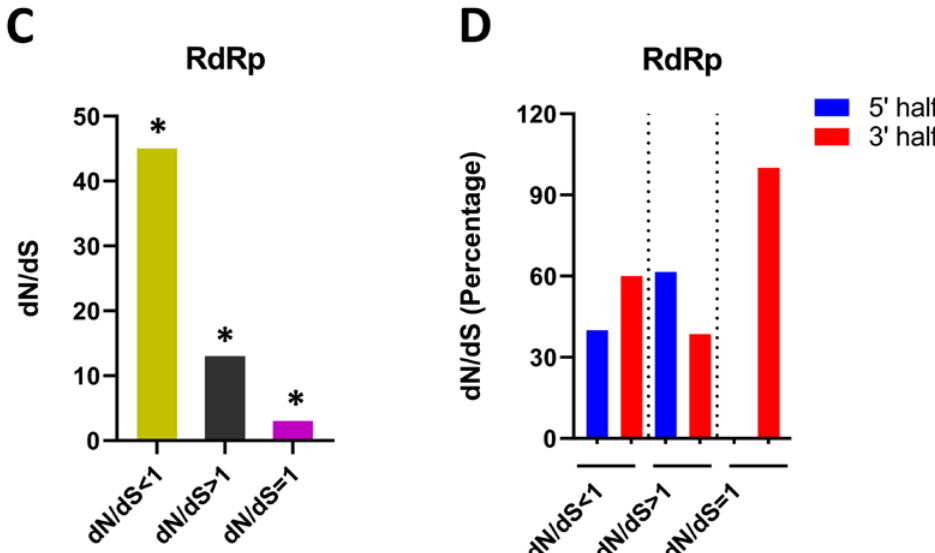
Figure 7. Estimation of positive (dN/dS > 1), negative (dN/dS < 1), and neutral (dN/dS = 1) selection acting upon codons of the major STV proteins (p42 and RdRp). ( A ) number and ( B ) percent distribution of p42 codons under positive, negative and neutral selection pressure, ( C ) number and ( D ) percent distribution of RdRp codons under positive, negative and neutral selection pressure. The * indicates that these sites were selected at the significance level of p < 0.1.